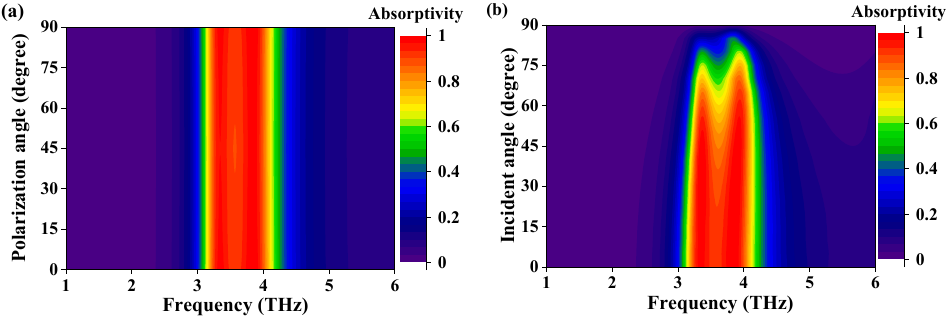
Figure 6. The simulated absorption spectra with ( a ) different polarization angles or ( b ) different incident angles.